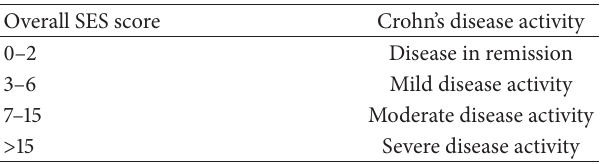
Table 1: Endoscopic activity of Crohn’s disease according to SES